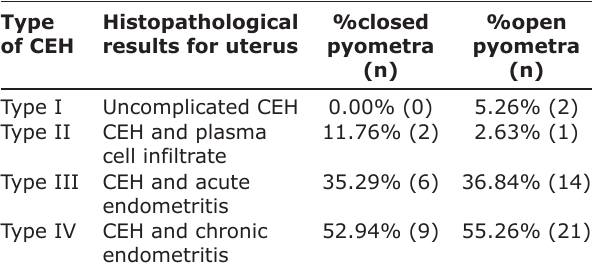
Table-9: Number of dogs with a specific type of CEH/total of closed pyometra cases (n = 17) and number of dogs with a specific type of CEH/total of open pyometra cases (n = 38) are presented as percentages. Type of CEH